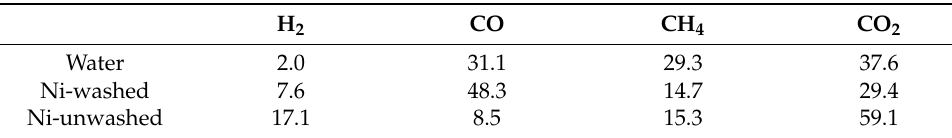
Table 5. The percentage of each gas in gas products (%). H 2 CO CH 4 CO